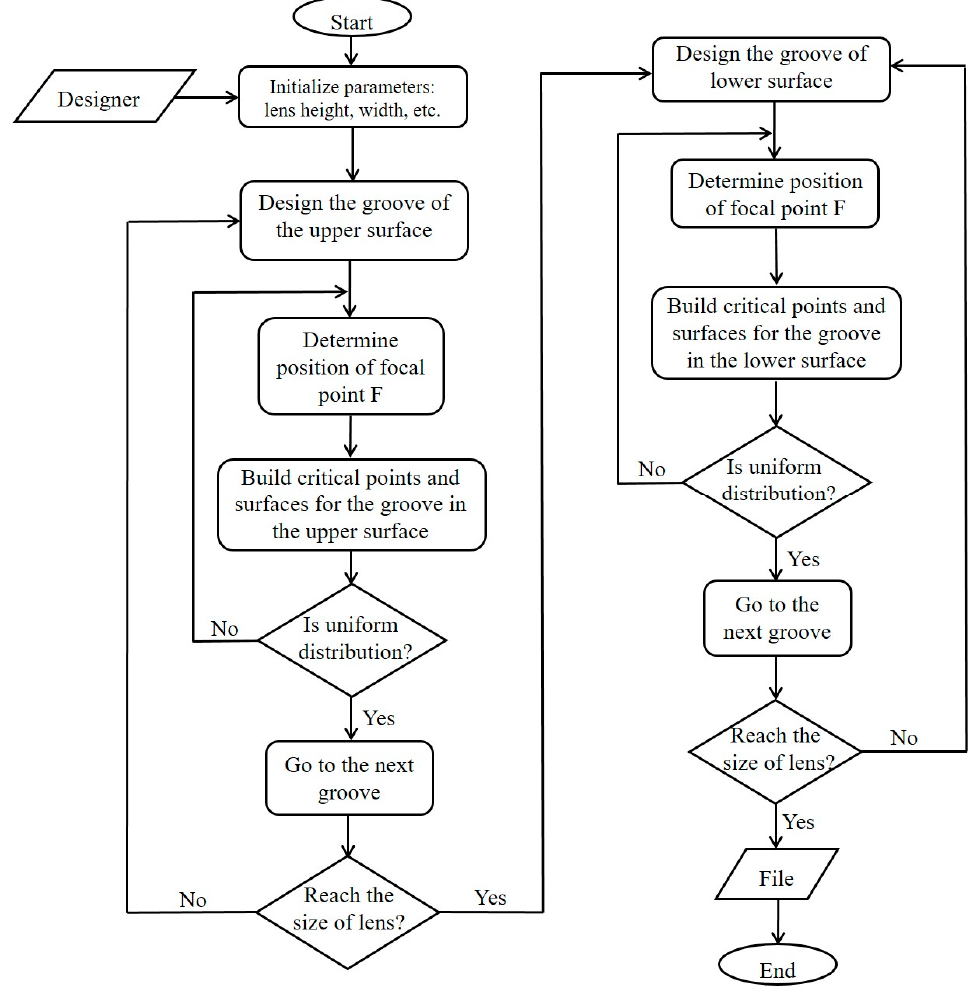
Figure 3. The flowchart of the lens designed in the MATLAB program.